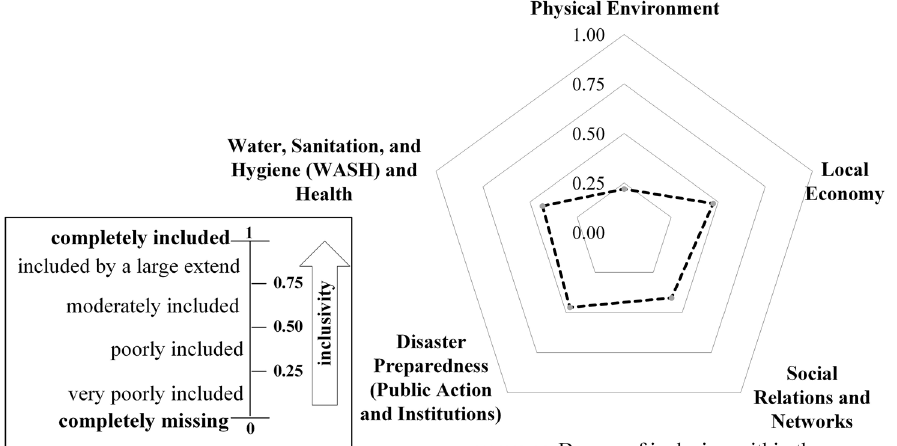
Fig. 5 Inclusion of the PAVR within Aila recovery in